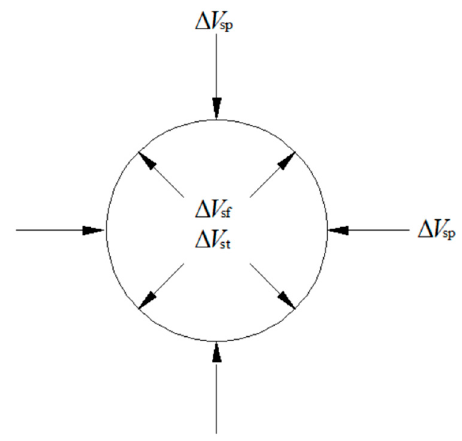
Figure 2. Deformation relationship of coal particles.